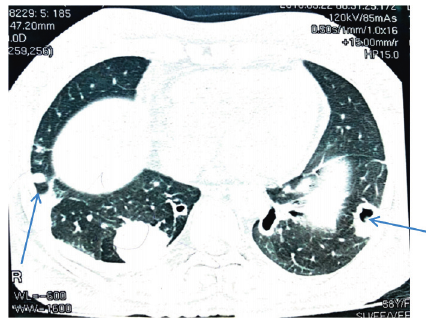
Figure 1: CT scan of lungs showing rheumatoid lung nodules.